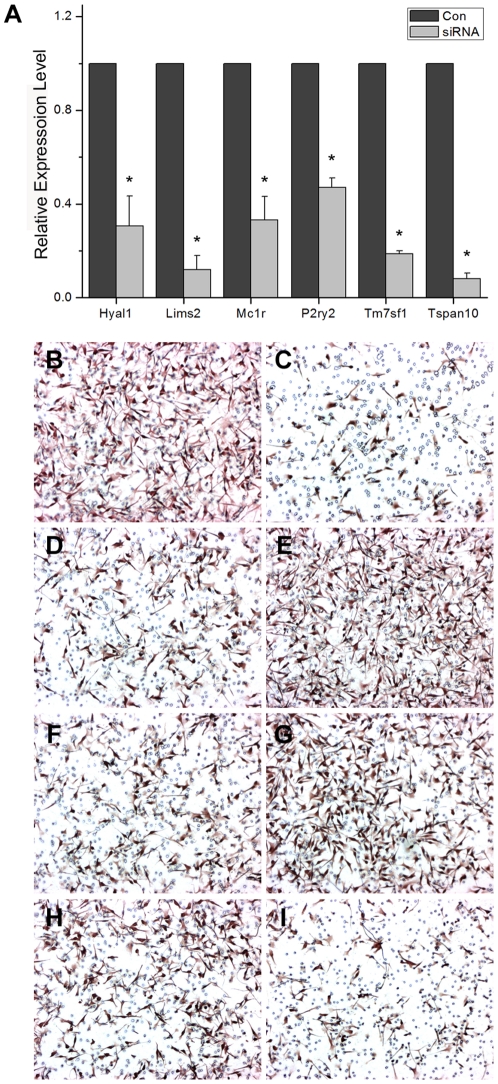
Targets of Sox10 regulate migration of B16F10 melanoma cells.(A) Quantitative RTPCR assay was carried out to test the efficacy of siRNAs directed for the selected genes. For each gene, the knockdown effect of the specific siRNA is expressed relative to that of a universal control siRNA (siCONTROL Non-Targeting siRNA #2) after normalization with GAPDH expression level. Values represent the average of three independent real-time PCR experiments each carried out in duplicates, and error bars represent standard deviations. The asterisk (*) represents a significant difference with the p value of <0.05. (B-I) B16F10 cells were treated with the universal control siRNA, WT1-Sox10 or a specific siRNA for each of the selected Sox10 target genes and subjected to transwell migration assay: Control (B), Sox10 (C), Hyal 1 (D), Lims2 (E), Mc1r (F), P2ry2 (G), Tm7sf1 (H), and Tspan10 (I). Representative results are presented.